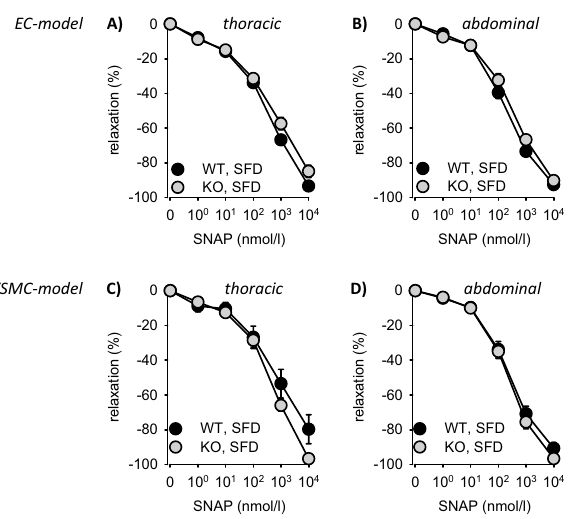
Figure 4. ( A , B ) Isometric relaxation of thoracic and abdominal aortic rings of EC-EGFR-KO and EC-EGFR-KO under SFD in response to SNAP. ( C , D ) Isometric relaxation of thoracic and abdominal aortic rings of VSMC-EGFR-KO and VSMC-EGFR-KO under SFD in response to SNAP. Number of animals in the EC-model: N(WT, SFD) = 10, N(KO, SFD) = 8. Number of animals in the VSMC-model: N(WT, SFD) = 10, N(KO, SFD) = 10. *p < 0.05 versus respective control. SFD standard diet, HFD high fat diet, WT wiltype, KO knockout, EC endothelial cell, VSMC vascular smooth muscle